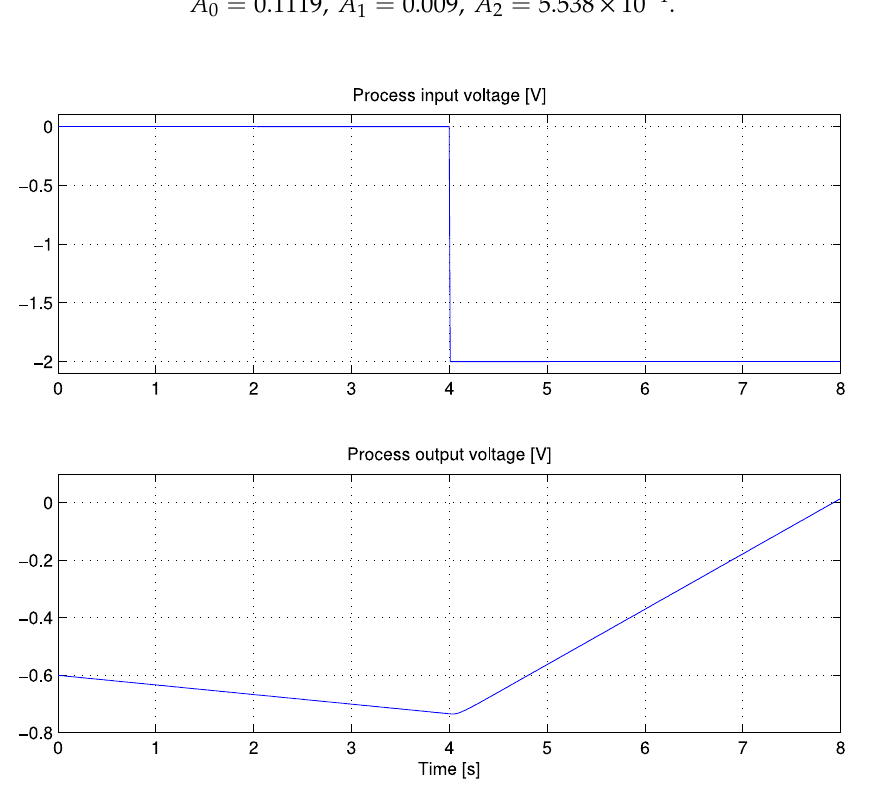
20 of 32 Figure 16. Closed-loop responses of G P4 process. PI controllers were tuned by MOMI, Ms14, and Ms20 methods. The fastest 5% settling time for reference change was obtained by the MOMI method. Similarly,